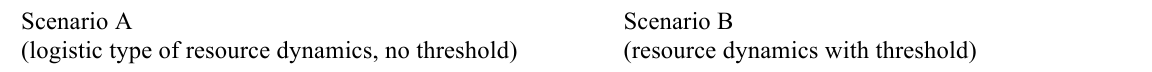
Table A5.1. Optimal claims for each resource stock size under the assumption that each group member believes that the game will continue one more round with a high enough